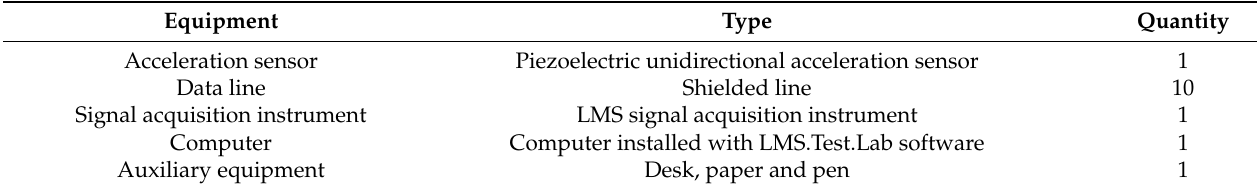
Table 4. Main equipment used for the verification experiment.